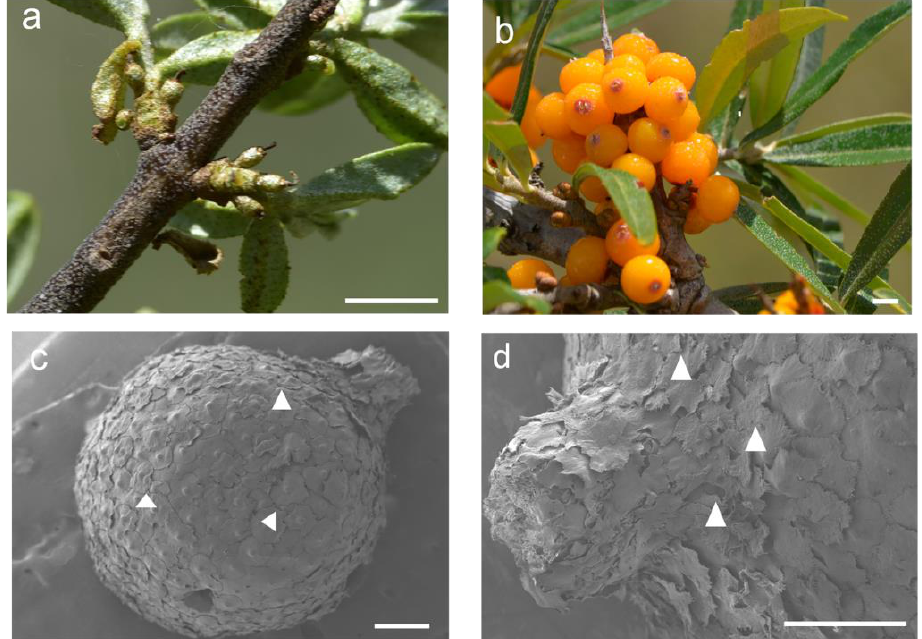
Figure 2. Morphological and microscopic images of H. rhamnoides ssp. sinensis fruit at 10 DAA and 120 DAA. ( a ) Fruits at 10 DAA, bar = 5 mm; ( b ) Fruits at 120 DAA, bar = 5 mm; ( c ) SEM micrographs show the fruit surface at 10 DAA, bar = 500 µm; ( d ) SEM micrographs show the fruit surface at 120 DAA, bar = 500 µm. The white triangle indicates the peltate trichomes of the perianth tube.